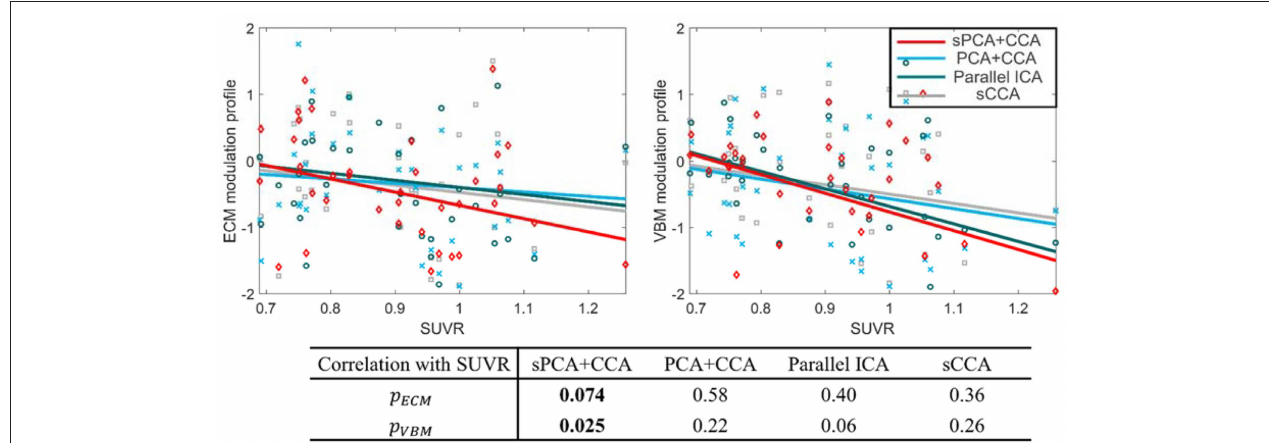
FIGURE 9 | Correlation between the most significant modulation profiles in ECM and VBM modalities with SUVR. The significance p -values for ECM ( p ECM ) and VBM data ( p VBM ) in sPCA + CCA, PCA + CCA, parallel ICA and sCCA are also shown. The SUVR measures the content of ß-amyloid using PET scanning. The ECM modulation profile of the disease-related pattern measures the strength of functional connectivity. A more negative value indicates lower functional connectivity.